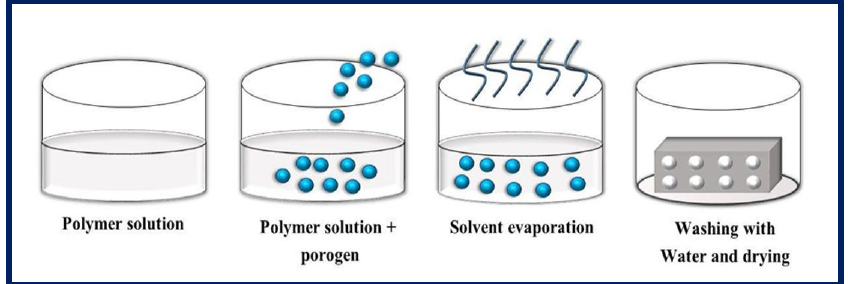
Figure 10. MM-PL process, where a polymer is mixed with a porogen to obtain porous scaffolds. Bibliography consulted [88].